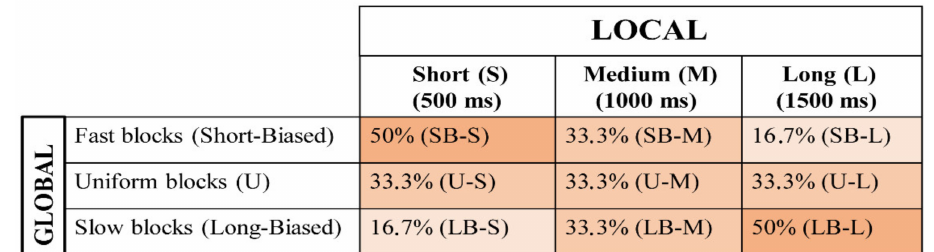
Figure 2. Experimental Design. The effect of global prediction was assessed by manipulating the between-block, a priori percentage of each SOA to create three probabilistic distributions in which the SOAs were equally distributed (uniform) or skewed toward the short (short-biased) or long (long-biased)